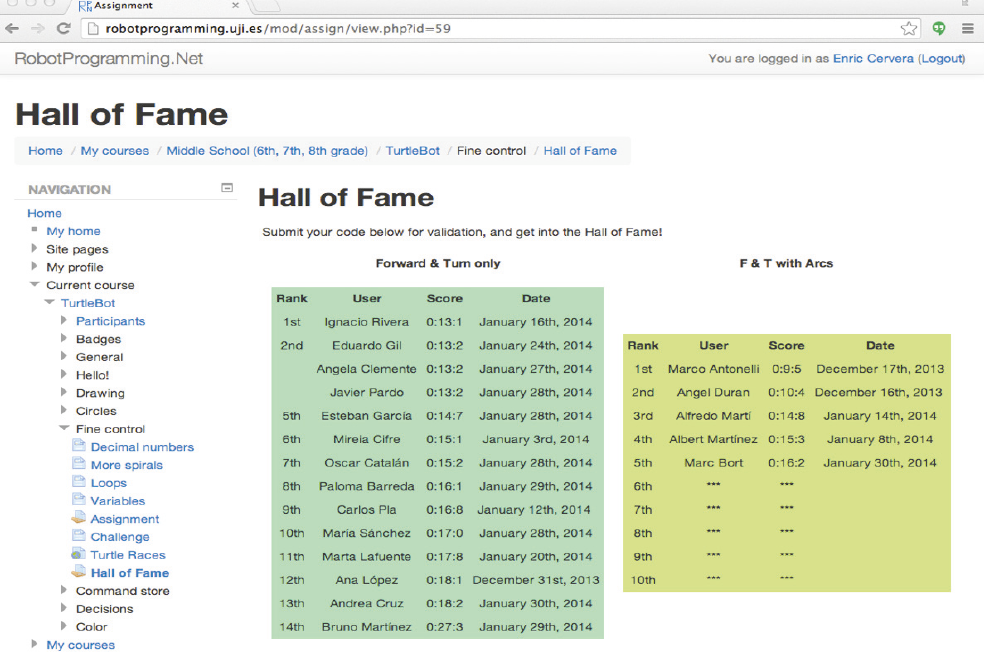
Figure 8: Image of the Hall of Fame with the students’